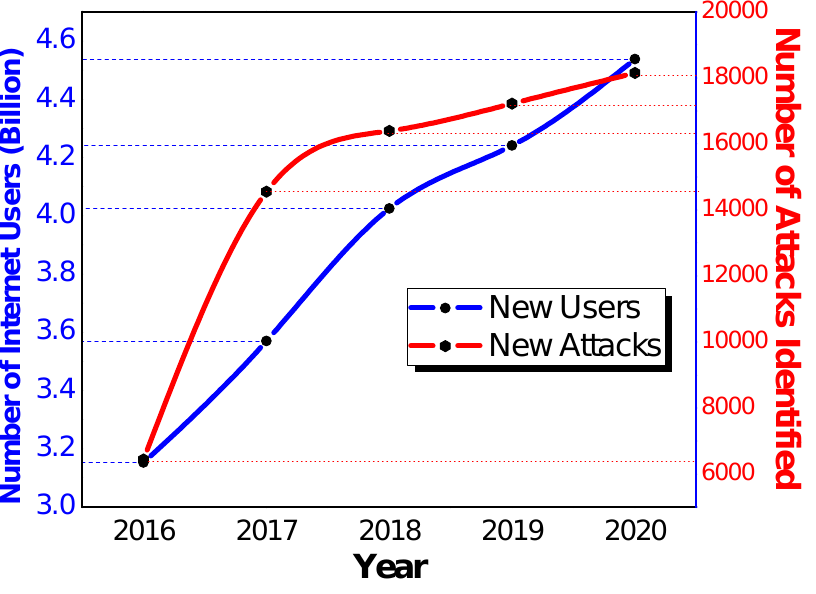
Figure 1. Number of Internet users and new